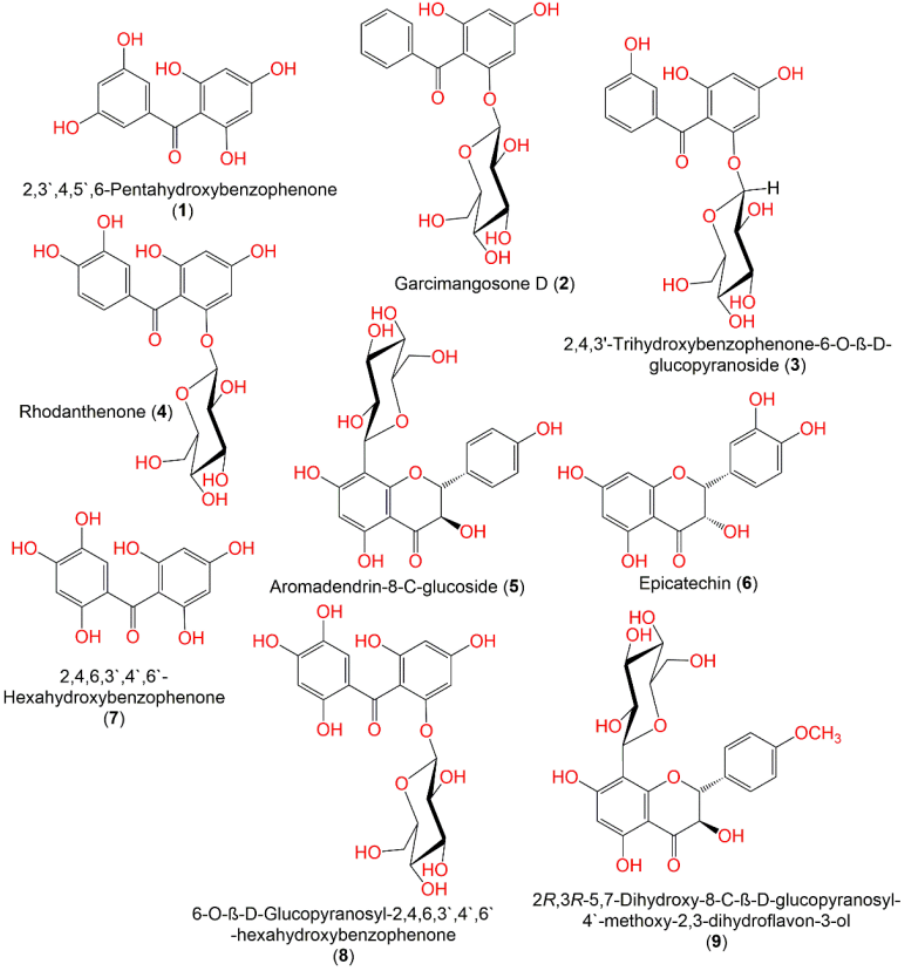
Figure 1. Structures of compounds 1 – 9 .